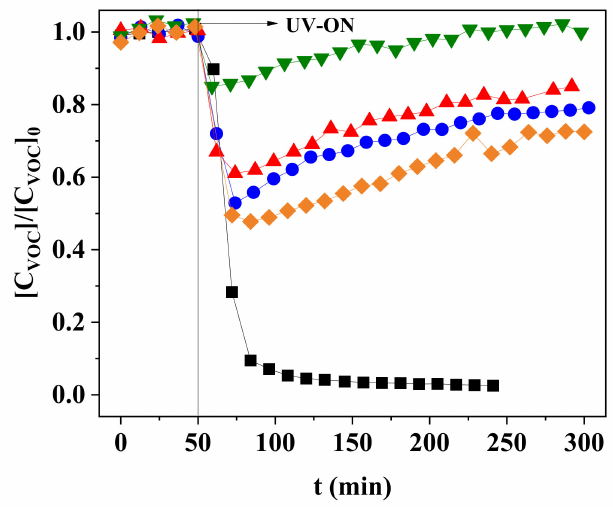
Figure 2. Profiles of n -decane removal by PCO using the NETmix photoreactor with different composite films: Z-1 ( (cid:4) ), PAZ-1 ( • ), PVZ-1 ( (cid:78) ), PZ-1 ( (cid:72) ), and PVZ-4 ( (cid:7) ). Conditions: irradiation intensity = 245.5 W m − 2 ; C VOC,feed = 78.8 ppm; Q feed = 150 cm 3 min − 1